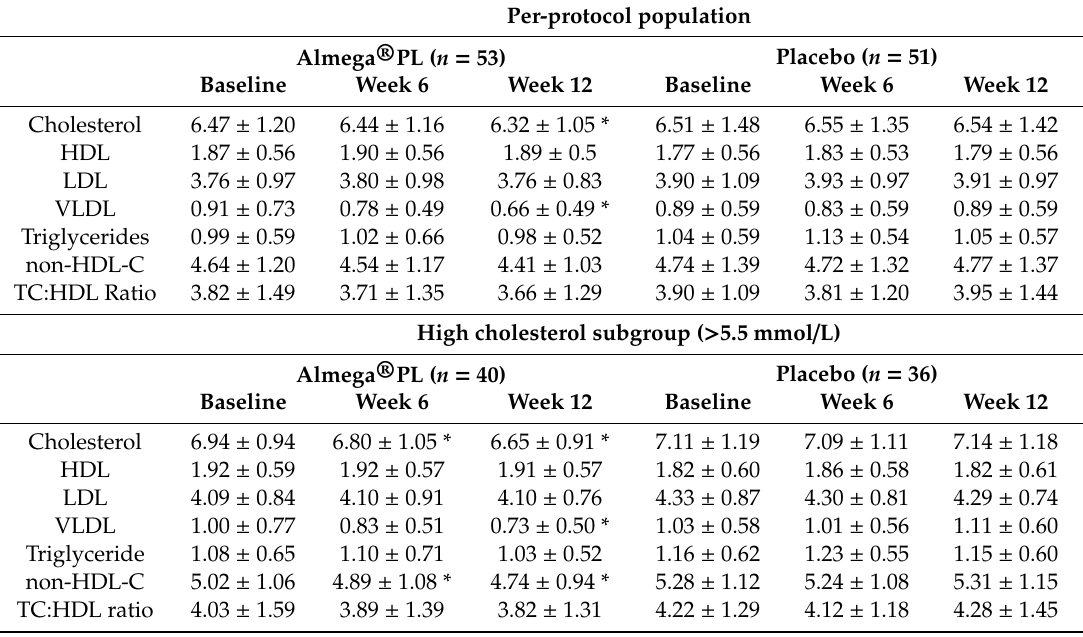
Table 3. Total cholesterol, HDL, LDL, VLDL, triglycerides, non-HDL-cholesterol, TC:HDL ratio and triglyceride in plasma (mmol /